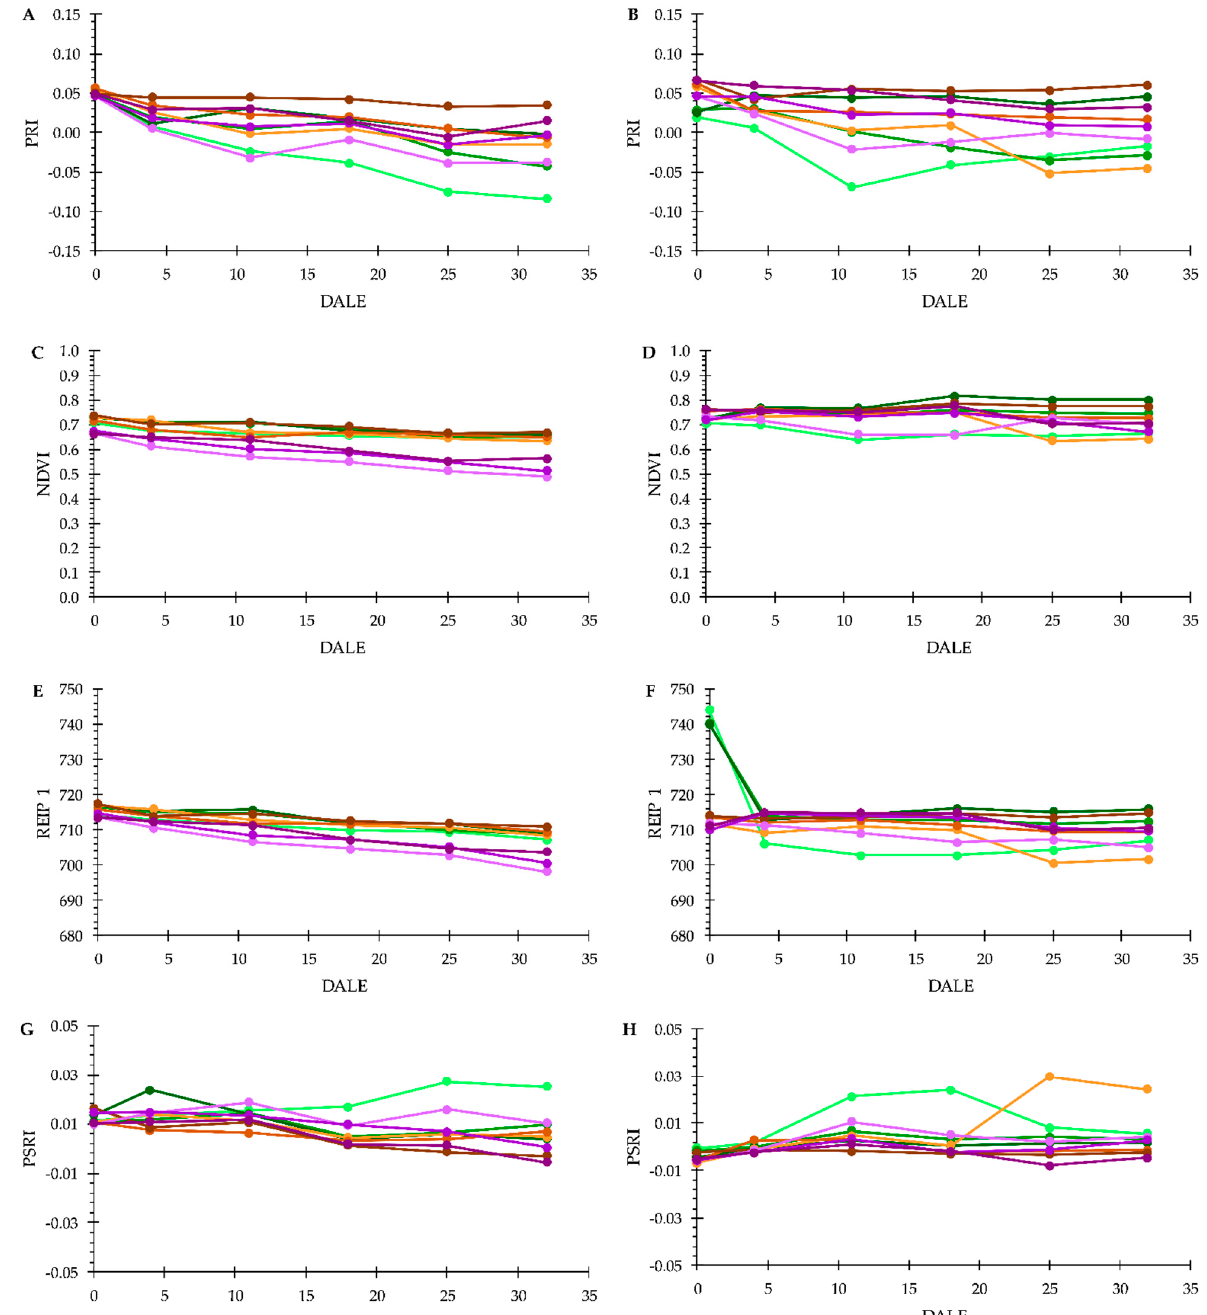
Figure 10. Performance-based vegetation indices for H. macrophylla subsp. serrata cultivars (green: ‘Oamacha’, orange: ‘Odoriko Amacha’, purple: ‘Amagi Amacha’) under different shading conditions (dark coloring: full shade, medium coloring: partial shade, light coloring: no shade) in 2018 ( A , C , E , G ) and 2019 ( B , D , F , H ). Full display of significant differences is reported in the Supplementary Materials Table S5.